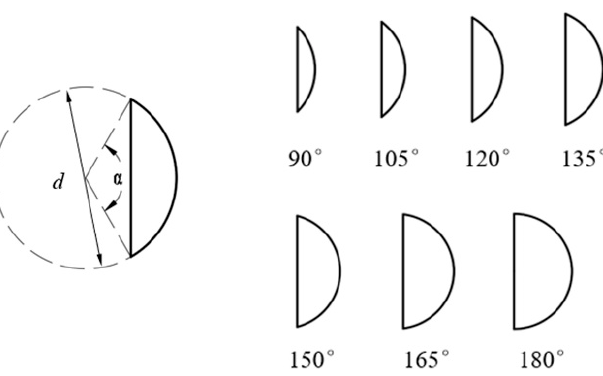
Figure 2. Illustration of the pipes having bow cross-sections with different central angles.